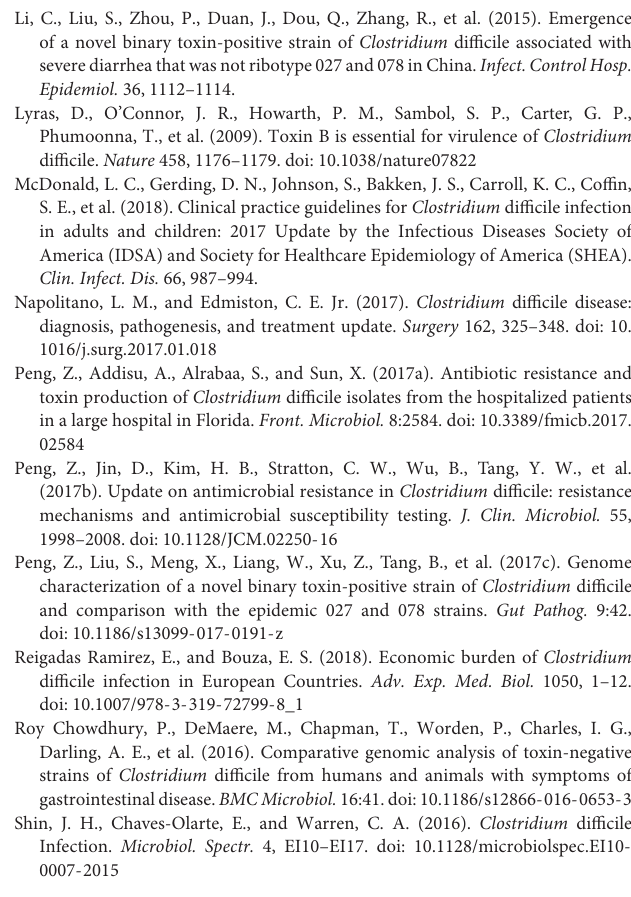
FIGURE S1 | Lytic activity of LHD on C. difficile R20291 in different pH conditions (pH 2–5). Prior to tests, bacterial optical density at 600 nm (OD 600 ) was adjusted to approximately 0.8–1.0. Protein LHD was added into the cell re-suspension with the final concentration of 100 µ g/ml. The drop in OD 600 at 37 ◦ C was measured once per 20 min for 60 min. Bacterial re-suspension with sterile water was also set as a control. Experiments were repeated 3 times, and representative data were